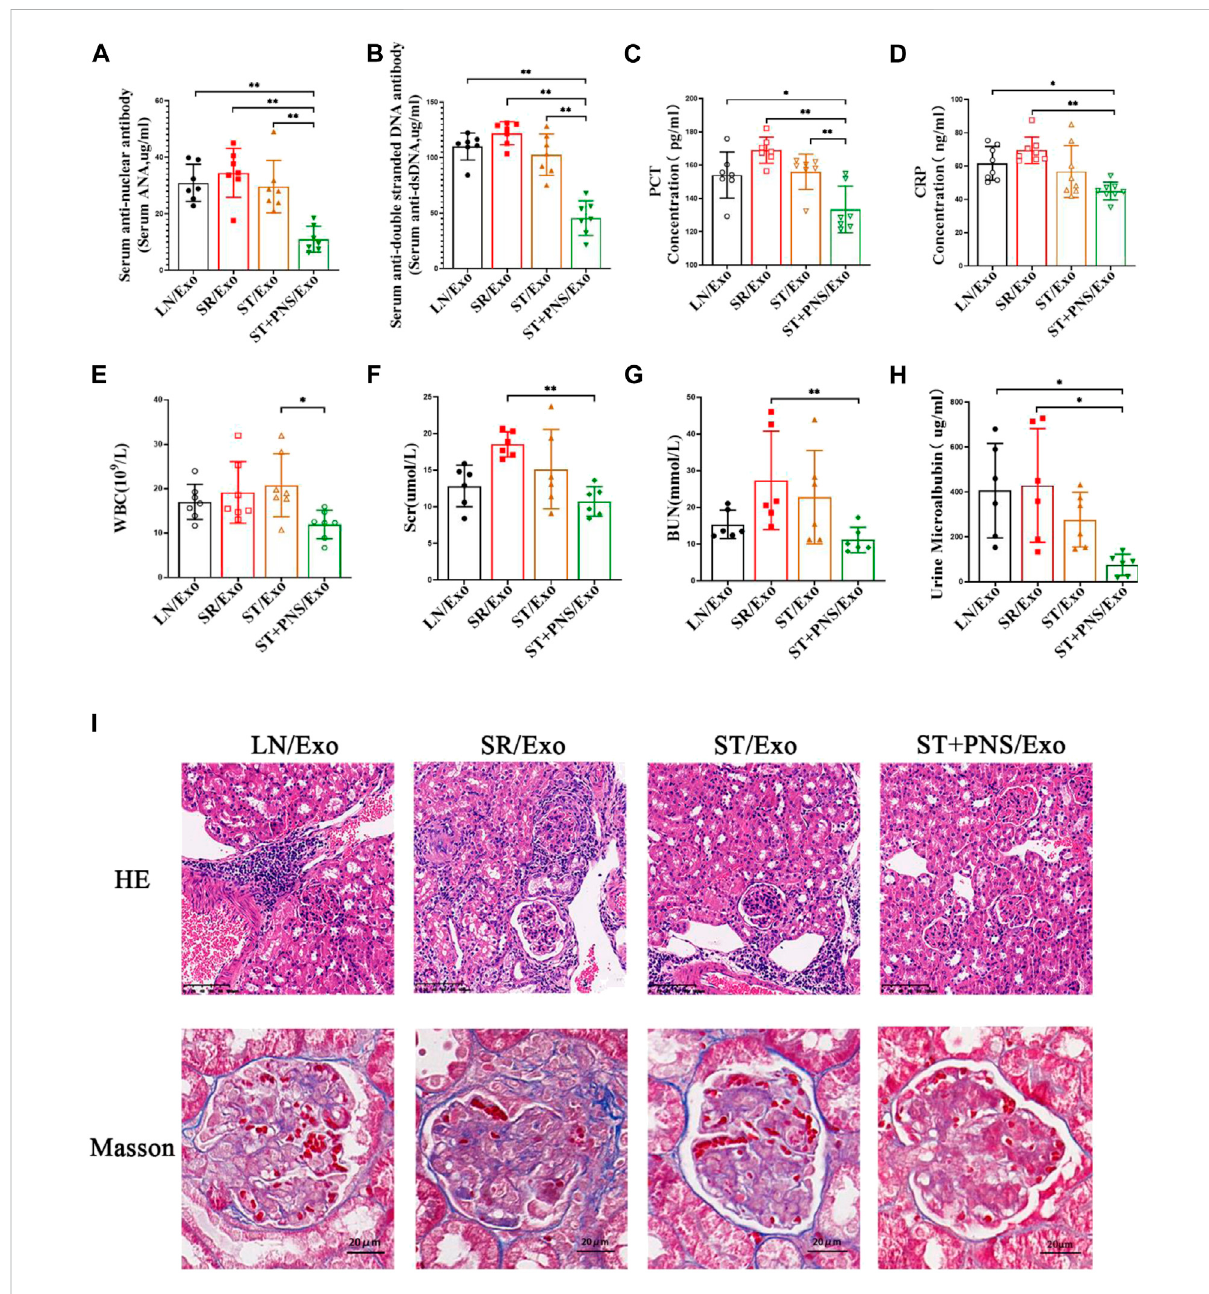
FIGURE 6 Evaluation of autoantibodies, in fl ammatory indexes, renal function, and renal pathological damage in each group of LN mice after different Lyme-Exointerventions. (A – D) Expression ofserumautoantibodyANA,dsDNA,andin fl ammatorymarkers(CRPandPCT)byELISA. (E) Whole-blood WBC assay by fully automated hematology analyzer. (F – G) Serum creatinine, urea nitrogen by automatic biochemical analyzer. (H) Urinary microalbumin excretion by fully automated protein analyzer. (I) Renal pathology HE and Masson staining (scale bars 100 μ m and 20 μ m). All data are expressed as the mean ± standard deviation from independent groups, *p < 0.05, **p <